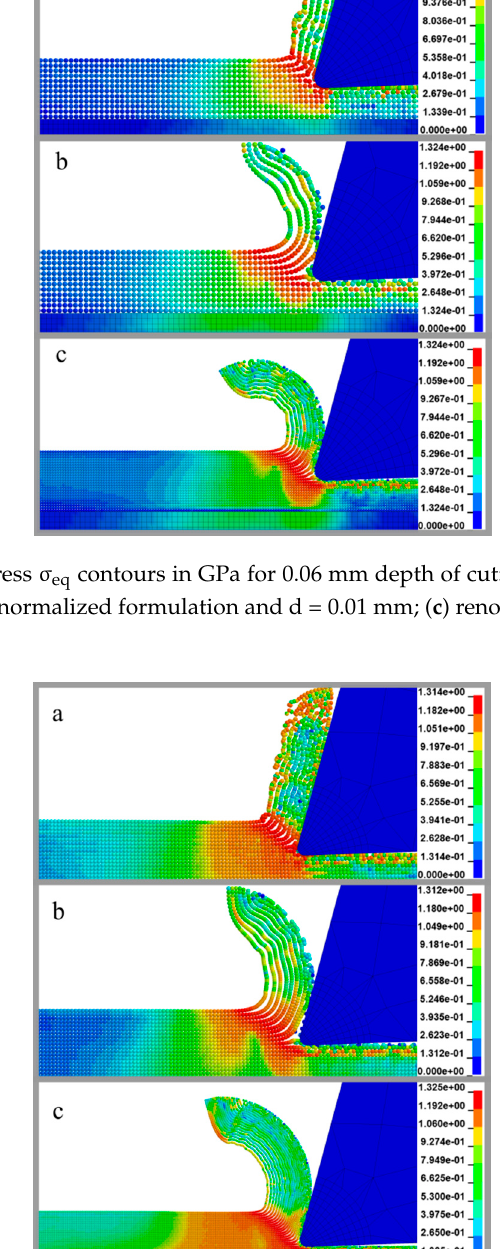
Figure 5. Equivalent stress σ eq contours in GPa for 0.1 mm depth of cut: ( a ) standard formulation and d = 0.01 mm; ( b ) renormalized formulation and d = 0.01 mm; ( c ) renormalized formulation and d = 0.005 mm.